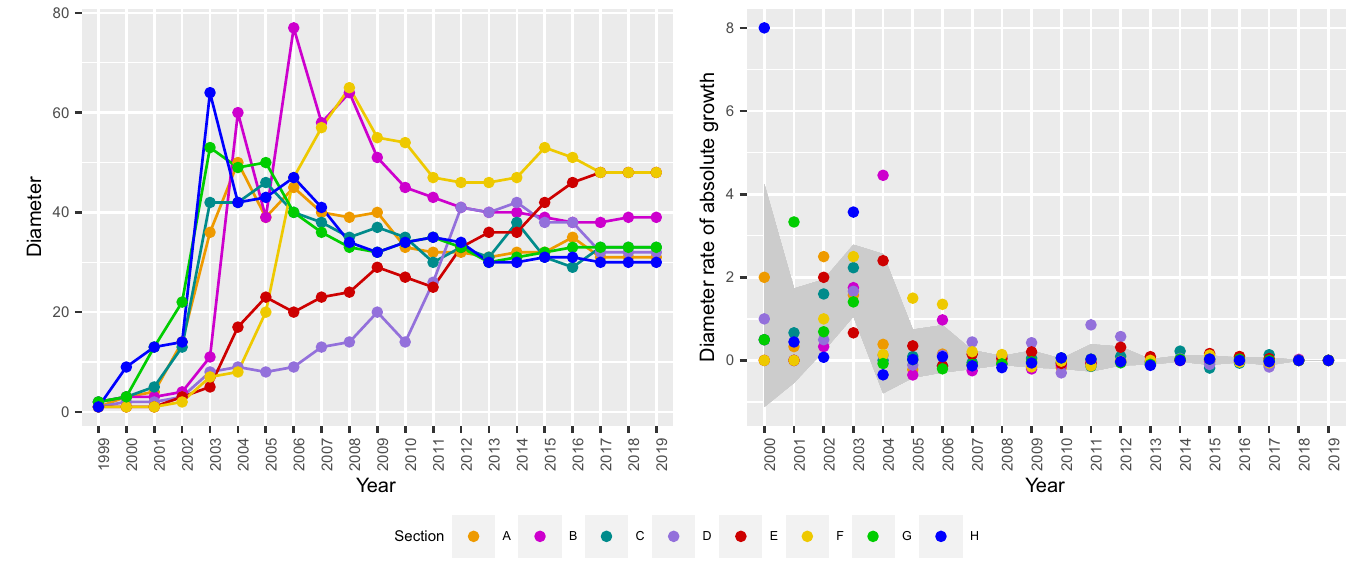
Fig 4. Diameter (left) and relative growth rate (right) over time by technological field, 1999–2019.